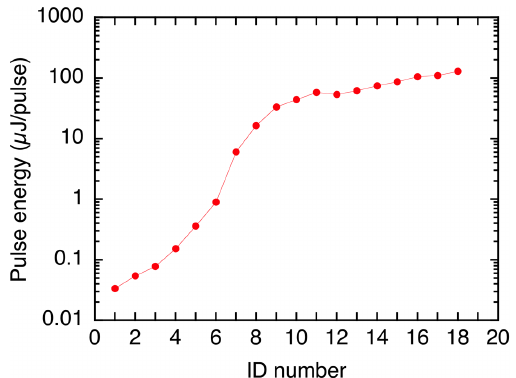
FIG. 12. FEL gain curve at 10-keV photon energy [1]. The photon pulse energy amplification is plotted as a function of the undulator number. The electron beam energy was 7